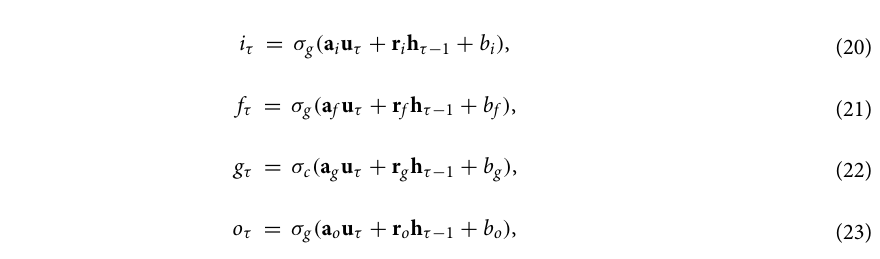
Figure 3. Procedure for classification of physiological time series with TF–TS LSTM: ( a ) from raw data to data balance in training and testing, ( b ) transformation of raw time series into time–frequency and time–space features, and ( c ) classification of testing